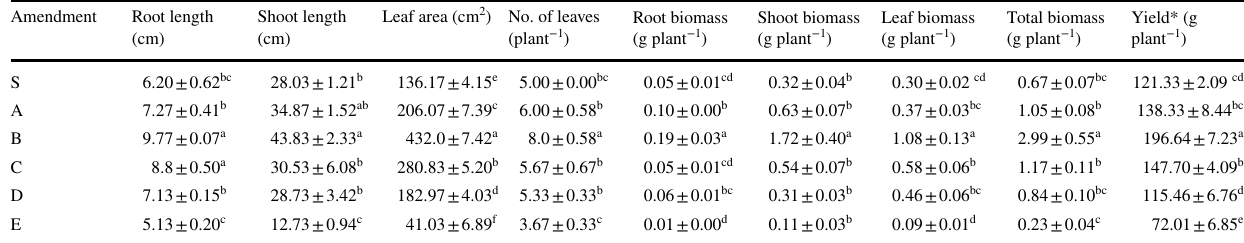
Table 3 Morphological characteristics (at 45 DAG) and yield* response (at 65 DAG) of lady’s finger (values ± SE)